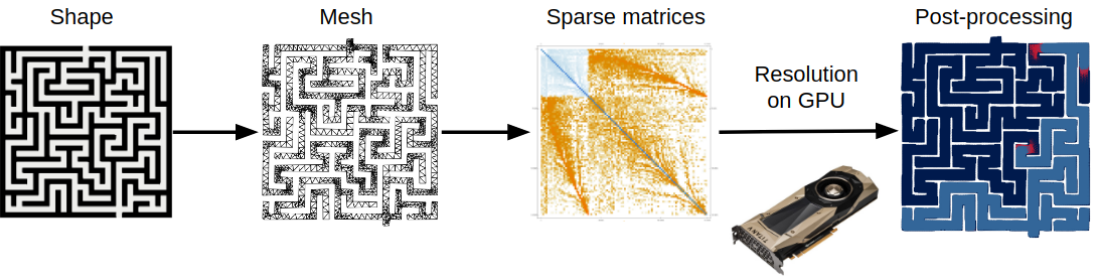
Figure 1. Workflow of our methodology. We start from a bitmap image of a maze that is discretized into a mesh with a FEM software, which then assembles the stiffness and damping matrices. We solve the matrix ordinary differential equations on the GPU, and then plot the results with the